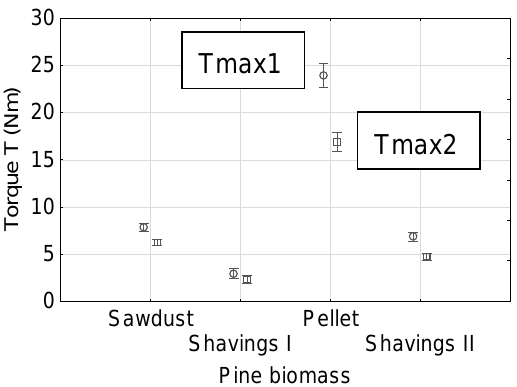
Figure 6. Mean value of the maximal shear torque with 0.95 confidence intervals for different types of biomass.